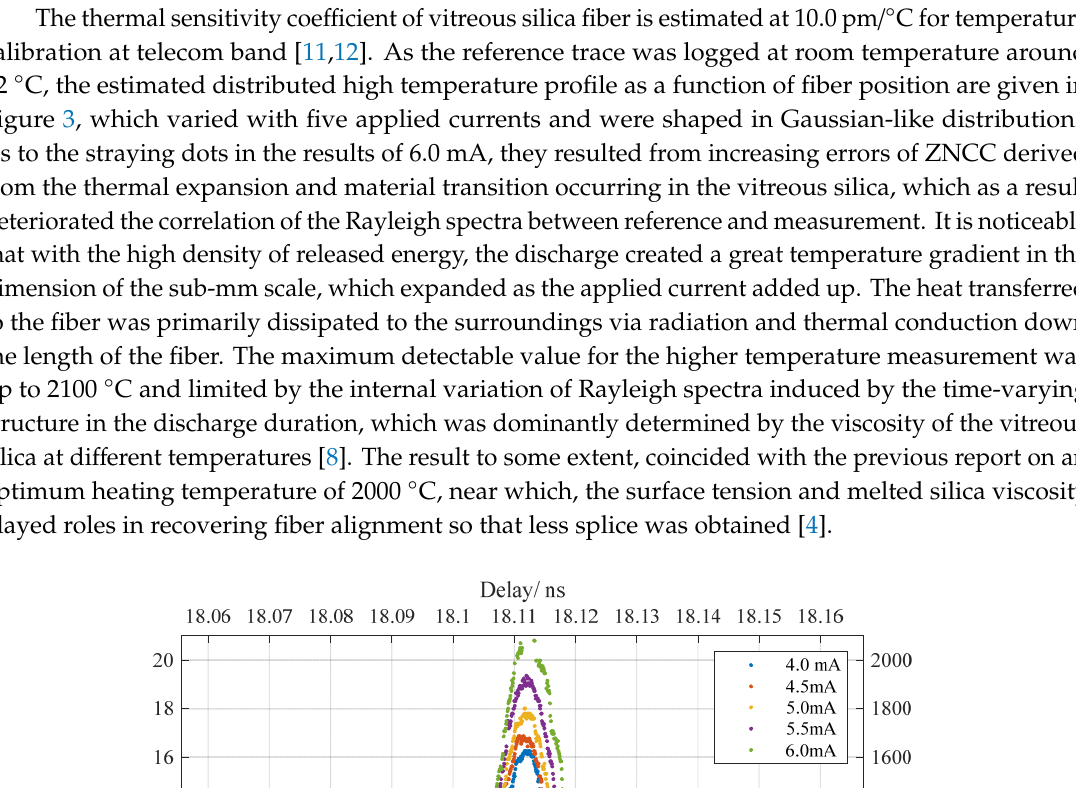
Figure 2. Demonstration of general method of calculating a thermal shift.